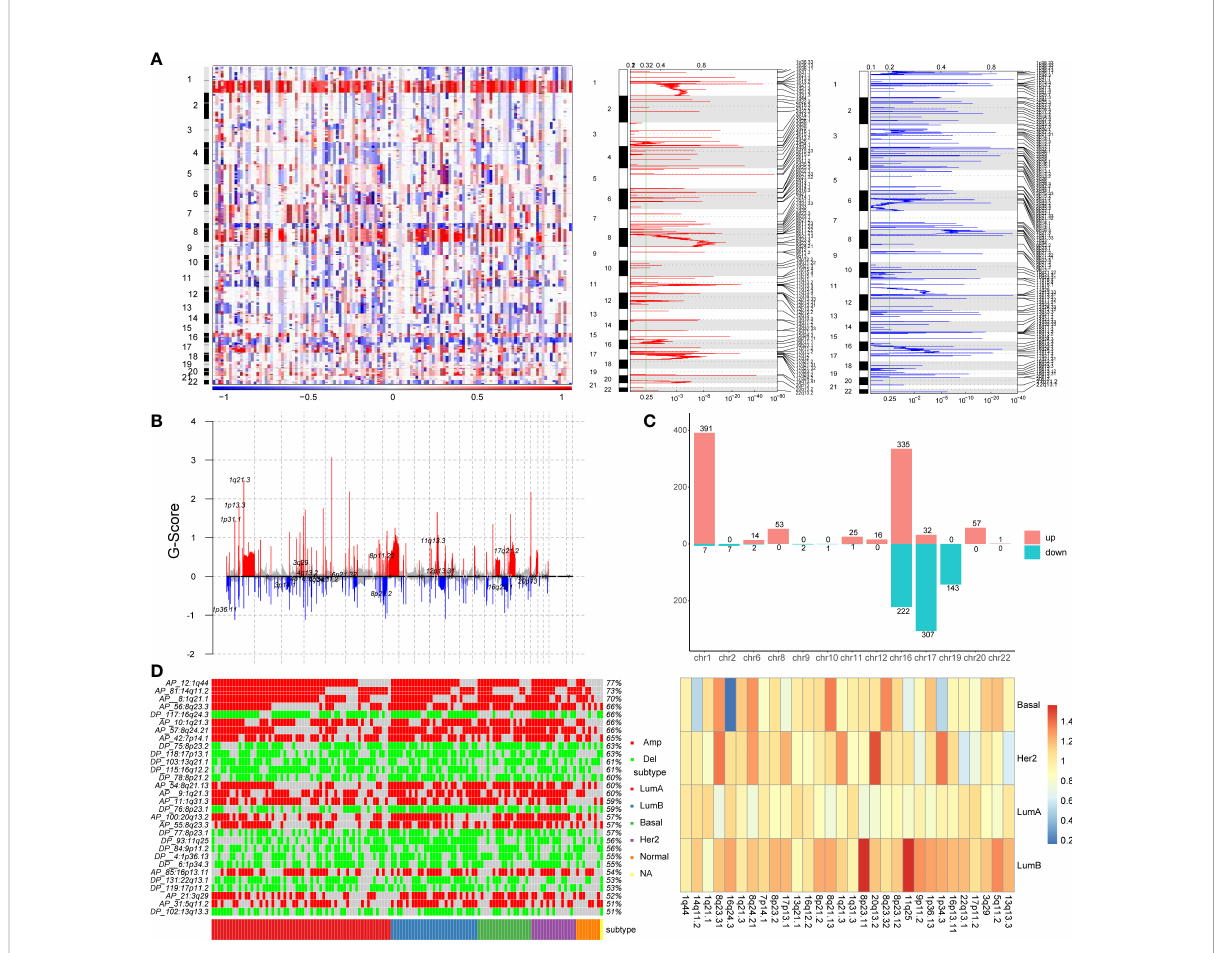
FIGURE 1 Identi fi cation of copy number variation-driven enhancers in breast cancer. (A) The analysis of copy number variation in breast cancer by GISTIC2.0. The left panel shows CNV variation heatmap, the middle panel shows copy number ampli fi cation regions and the right panel shows copy number deletion regions. (B) Waterfall plot of CNV rates in breast cancer. The red line indicates copy number ampli fi cation and the blue line indicates copy number deletion. (C) Chromosomal distribution of copy number variation-driven enhancers. (D) Comparative analysis of signi fi cant copy number variation regions in four subtypes of breast cancer. The left panel shows illustrates the variation of the signi fi cant CNV region in four subtypes and the overall mutation rate of these CNV region. The right panel shows a heatmap of folds of CNV mutation rate of each subtypes and total mutation